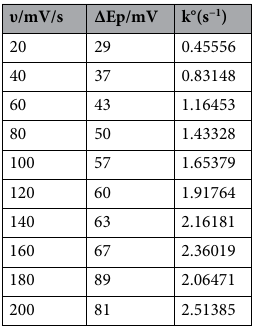
Table 3. Heterogeneous rate constant of DOA at different speed